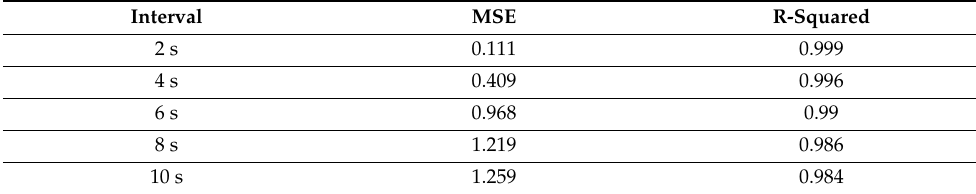
Table 11. RSRP prediction test results using LSTM.